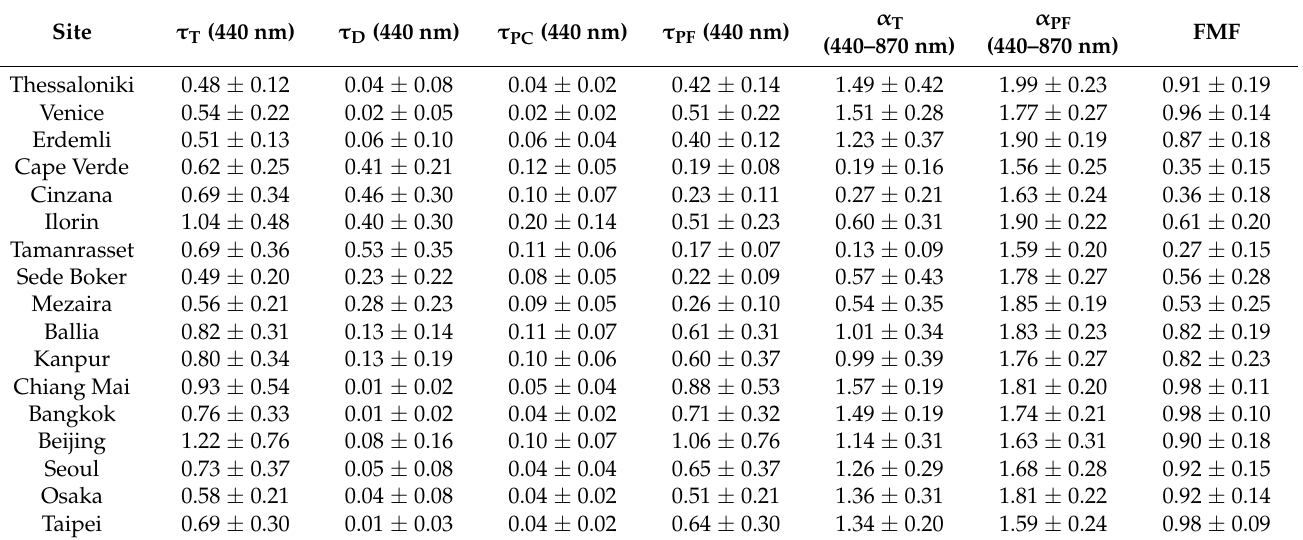
Table 1. Average and standard deviation of aerosol optical depth of total ( τ T ), dust ( τ D ), coarse-mode particles ( τ PC ) and fine-mode particles ( τ PF ) at 440 nm, and Ångström exponent (440–870 nm) of total ( α T ) and fine-mode particles ( α PF ), and fine-mode fraction (FMF) for the period